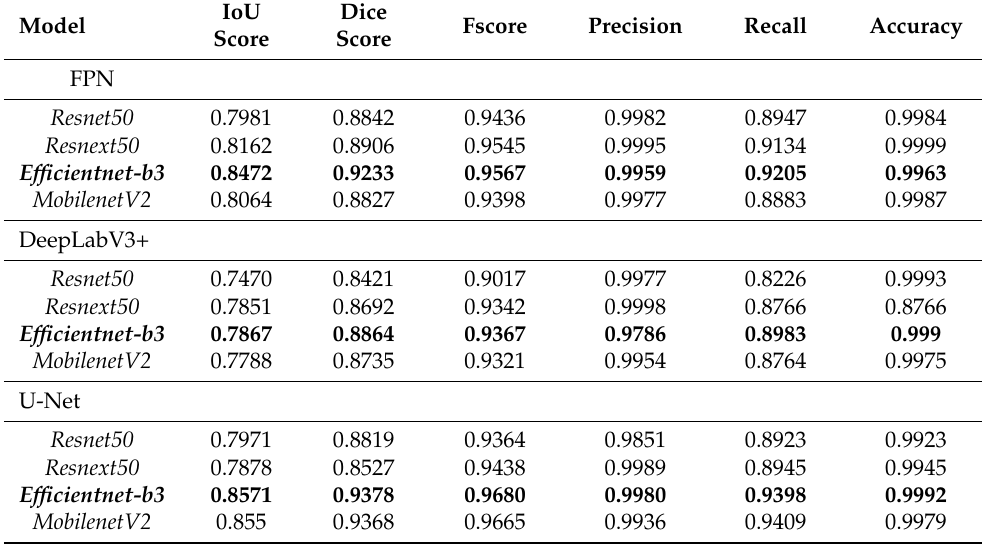
Table 4. PV plant faults detection and segmentation results with different